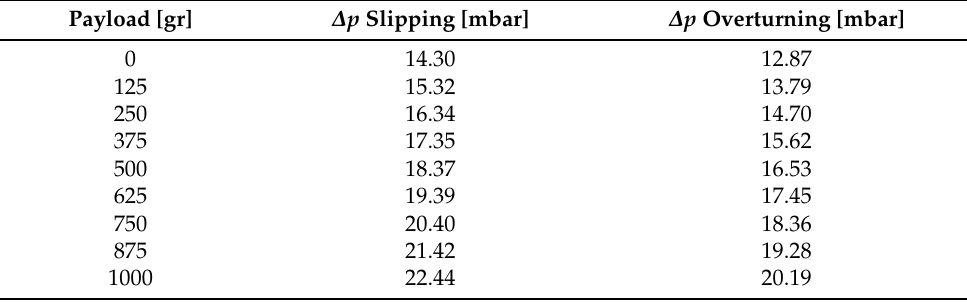
Table 2. Vacuum pressure requirement for different payload